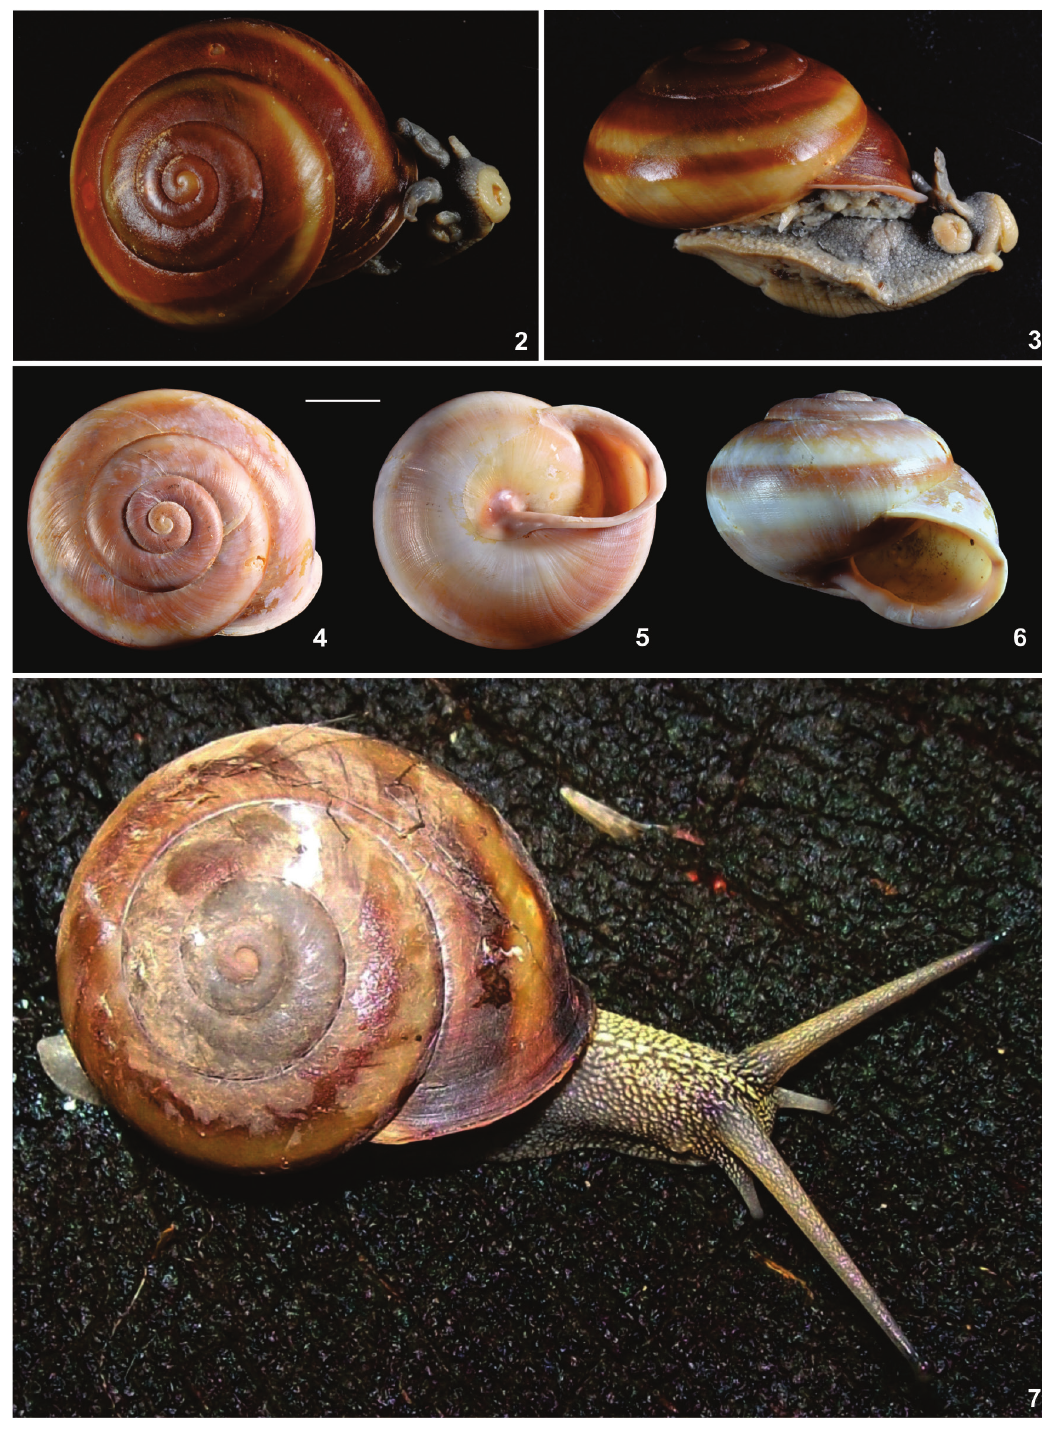
Figures 2–7. Shell morphology: (2) Dorsal view of Holotype, MNRJ 34.580; (3) lateral position of holotype shell and soft body; (4) dorsal, (5) ventral, and (6) lateral view of paratype, IBN 861; (7) live snail. Scale bar: 3–5 = 10 mm. ZOOLOGIA 34: e13230 | DOI: 10.3897/zoologia.34.e13230 | April 27,